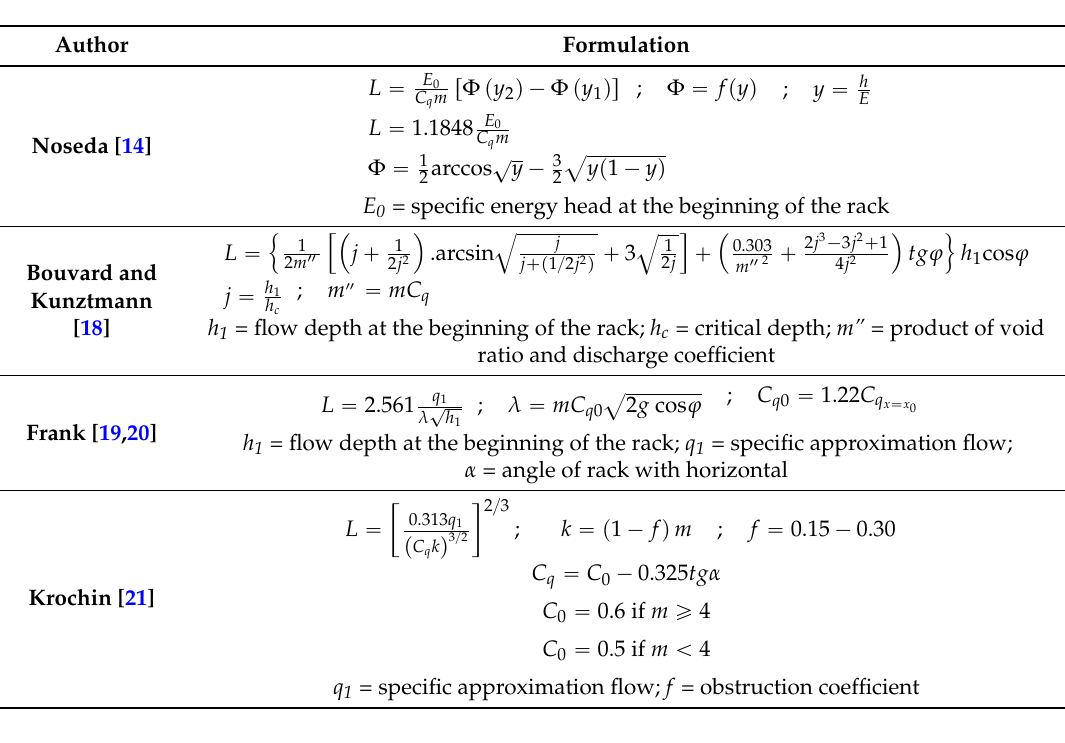
Table 1. Formulations for wetted rack